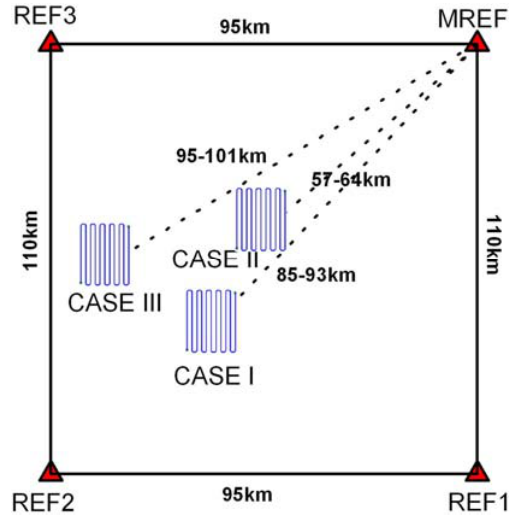
Figure 3. Layout of the GPS multiple reference station and testing